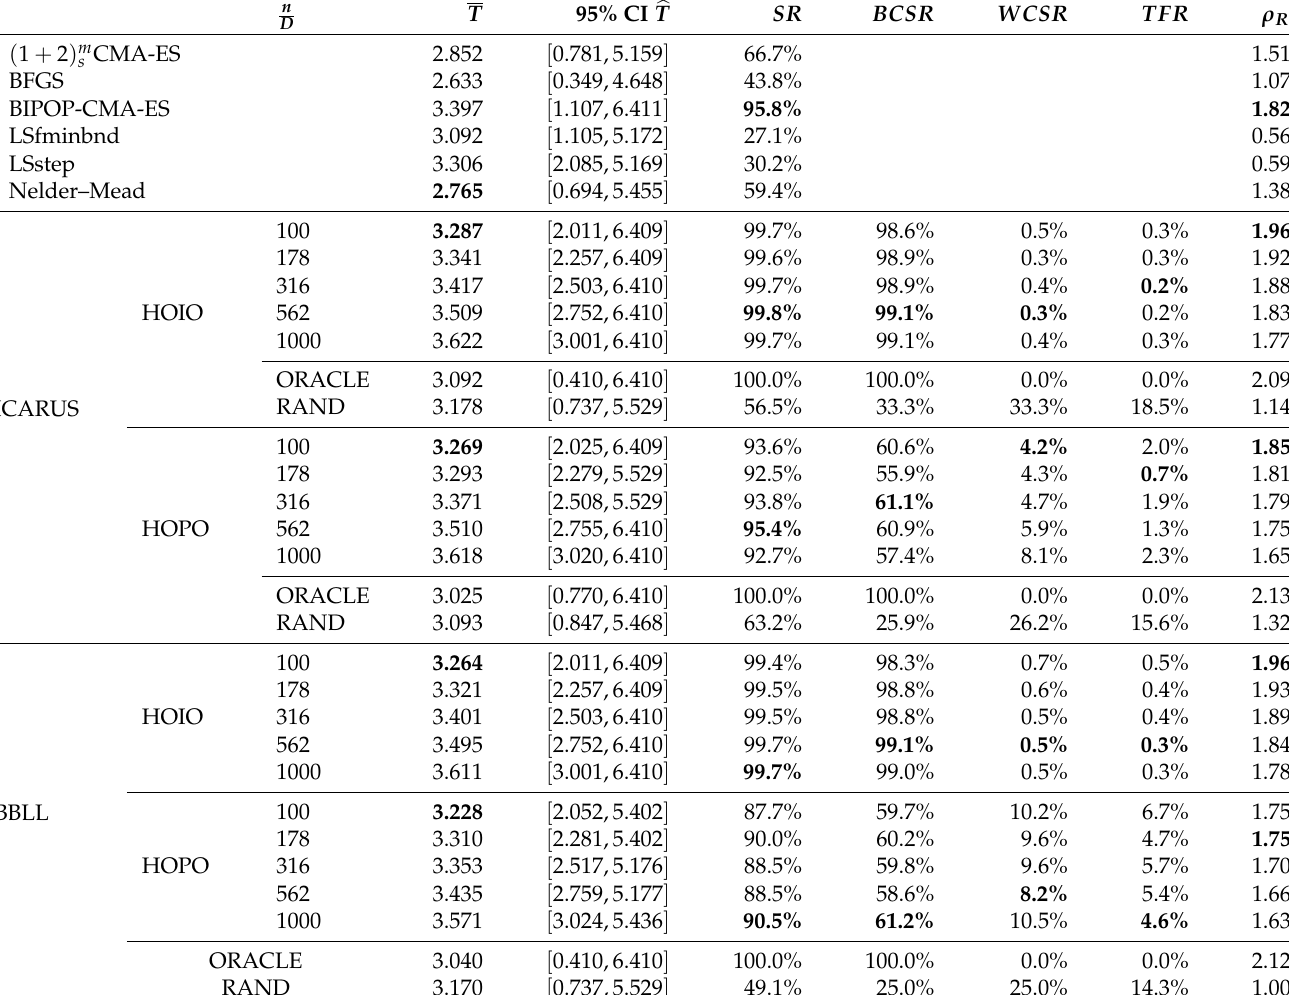
Table 3. Performance of each algorithm and the selector, in terms of T , 95% confidence interval of (cid:98) T , SR and ρ RB , which is the normalized performance score against random selection using the BBLL portfolio. In boldface are the lowest values for each performance measure over each validation method and n